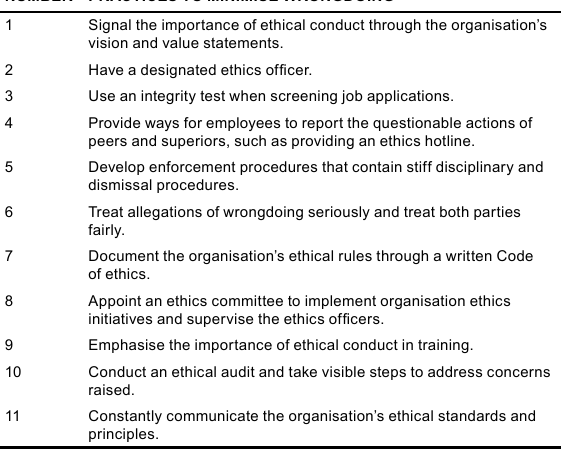
Table 1 Practices to minimise wrongdoing Number PracTices To miNimise